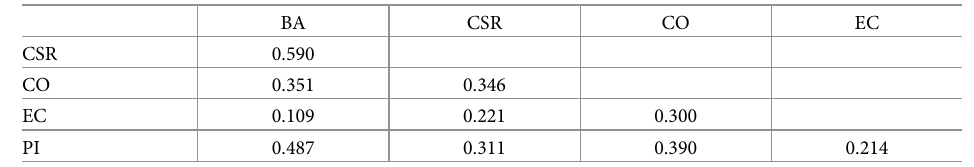
Table 4. Discriminant validity.